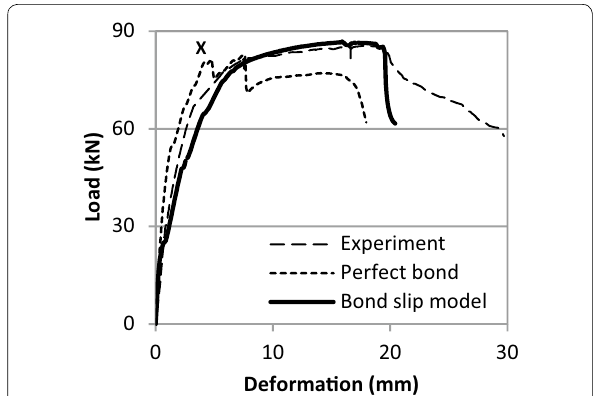
Fig. 6 Comparison of the results of bond-slip model for beam